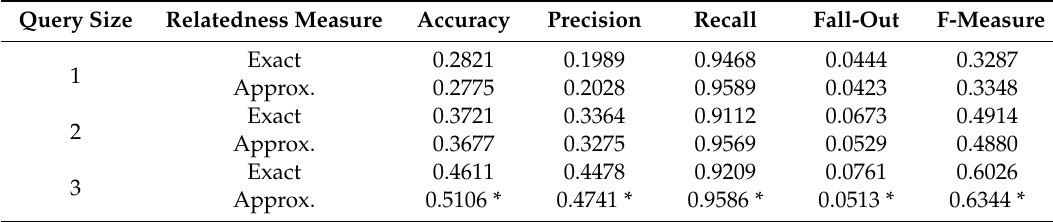
Table 1. Aggregated retrieval performance measures in classifications optimized for recall.